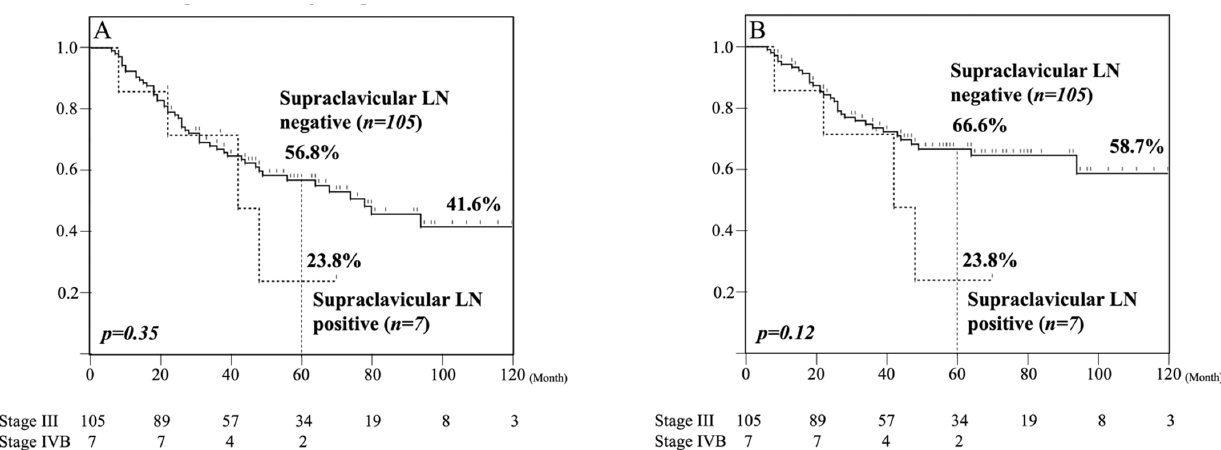
Figure 2. Kaplan–Meier analysis of clinical Stage III and IVB patients. The five-year OS was 57.6% among clinical Stage III patients and 41.3% among Stage IVB patients ( A ). The five-year DSS was 66.4% among clinical Stage III patients and 51.6% among Stage IVB patient. ( B )